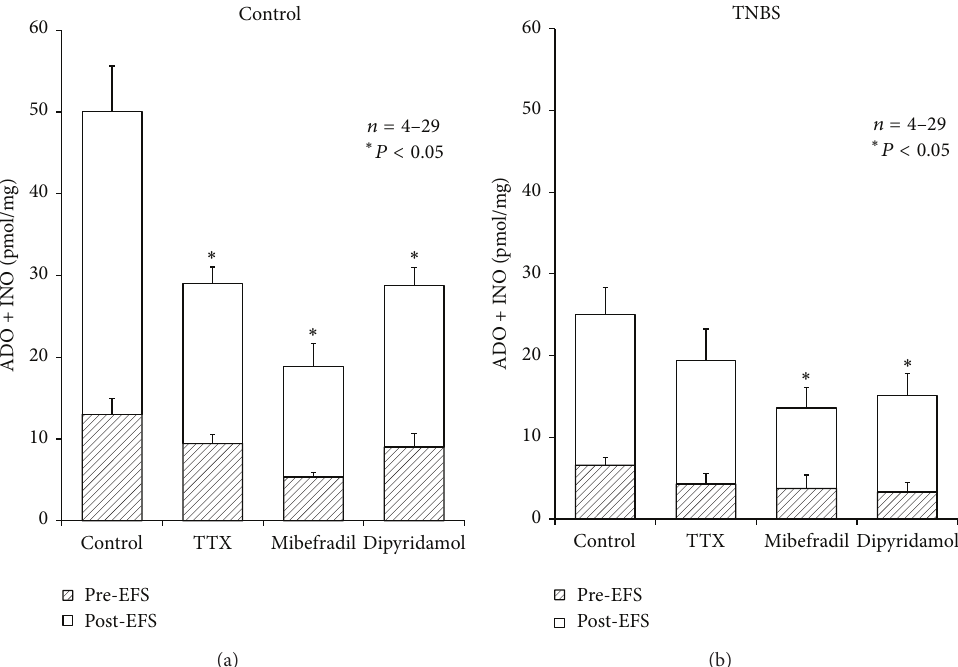
Figure 4: Influence of tetrodotoxin (TTX, 1 𝜇 M), mibefradil (3 𝜇 M), and dipyridamole (0.5 𝜇 M) on stimulation-evoked release of purine nucleosides (adenosine plus inosine) from the LM-MP of control and TNBS-injected rat ileum. Drugs were in contact with the preparations for at least 15min before stimulus application (5Hz frequency, 3000 pulses of 1ms duration). Samples collected from the incubation media were analysed by HPLC with diode array detection. Illustrated is the purine nucleosides content of bath samples collected immediately before (Pre-EFS) and after (Post-EFS) stimulation of LM-MP expressed in pmol/mg of tissue. Data represent the means ± SEM of an 𝑛 number of individual experiments. ∗ 𝑃 < 0.05 (one-way ANOVA followed by Dunnett’s modified t -test) represents significant differences from the evoked amount of purine nucleosides detected in control conditions where no drugs were added to the preparations.